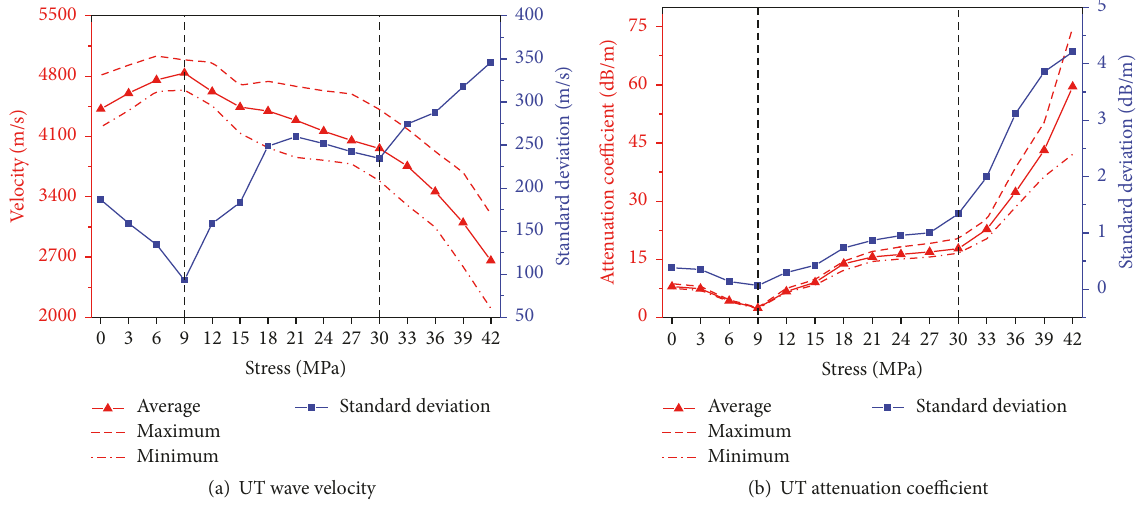
Figure 6: The evolution of UT parameters under different applied